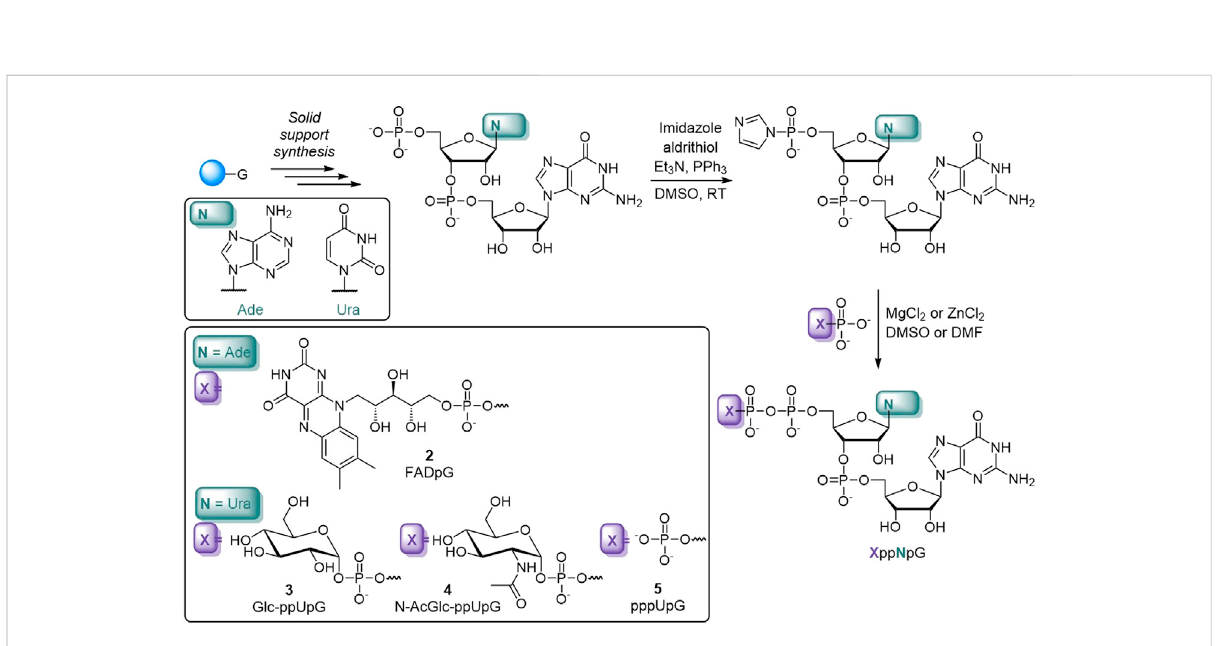
SCHEME 1 Representative syntheses of the non-canonical caps used in this